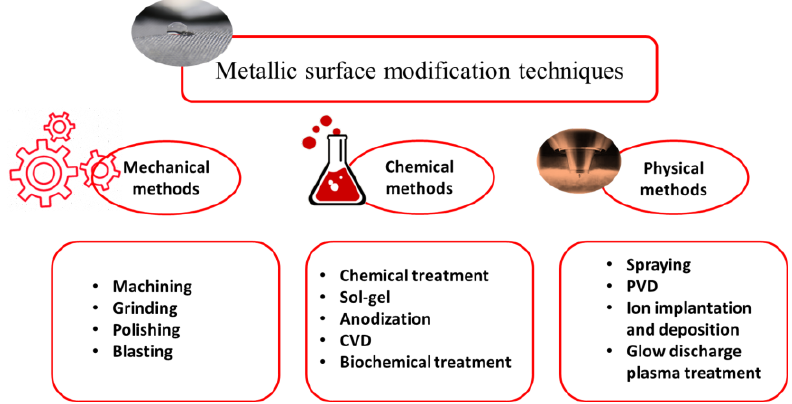
Figure 1. Metallic surface modification classification according to the type of technique.